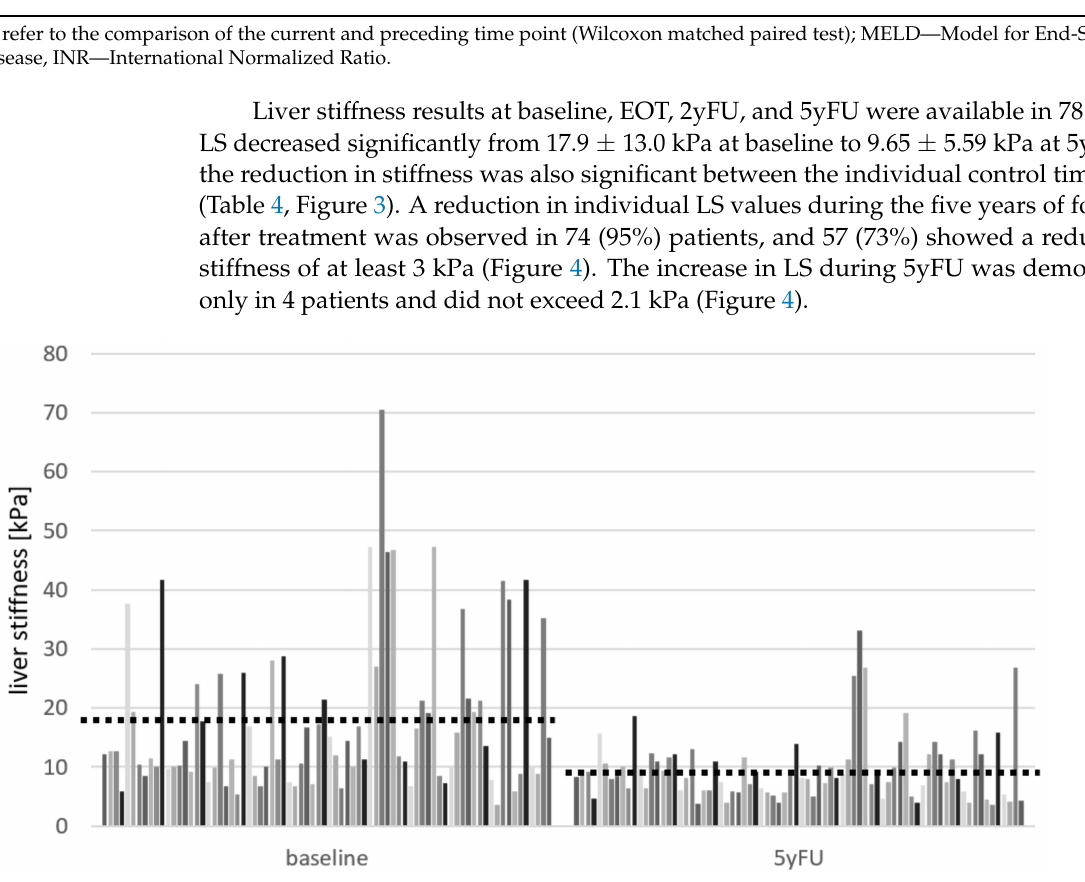
Figure 3. Individual values (bars) and mean (dashed horizontal line) of the liver stiffness (kPa) measured at the baseline (before start of the treatment) and 5yFU (5 years following end of treatment) in patients with available paired